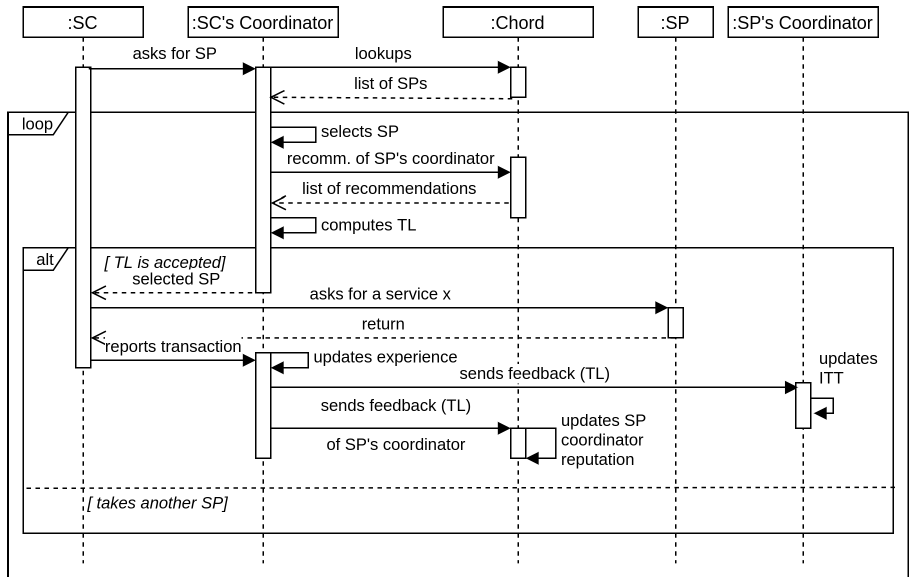
Figure 5. Sequence of steps during a trust